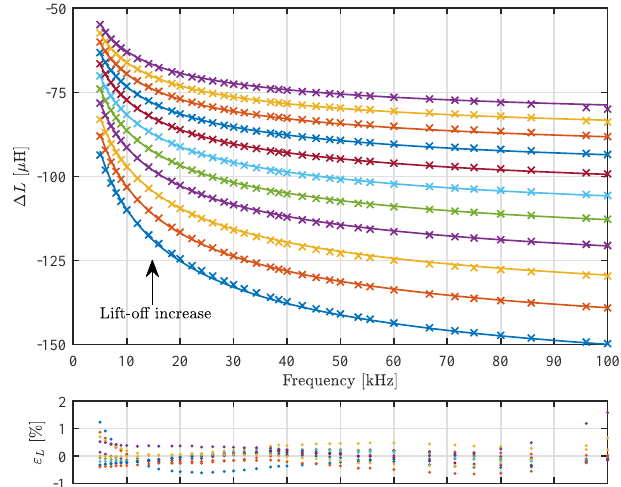
Figure 7. Imaginary part ∆ L of impedance change ∆ Z . Full lines are modeling results and crosses are measured values. The bottom curve is for lift-off 0µm and the top curve for 1000µm. Other curves are in 100µm increments. The graph bellow shows error ε L of individual measurement data points relative to the model prediction.